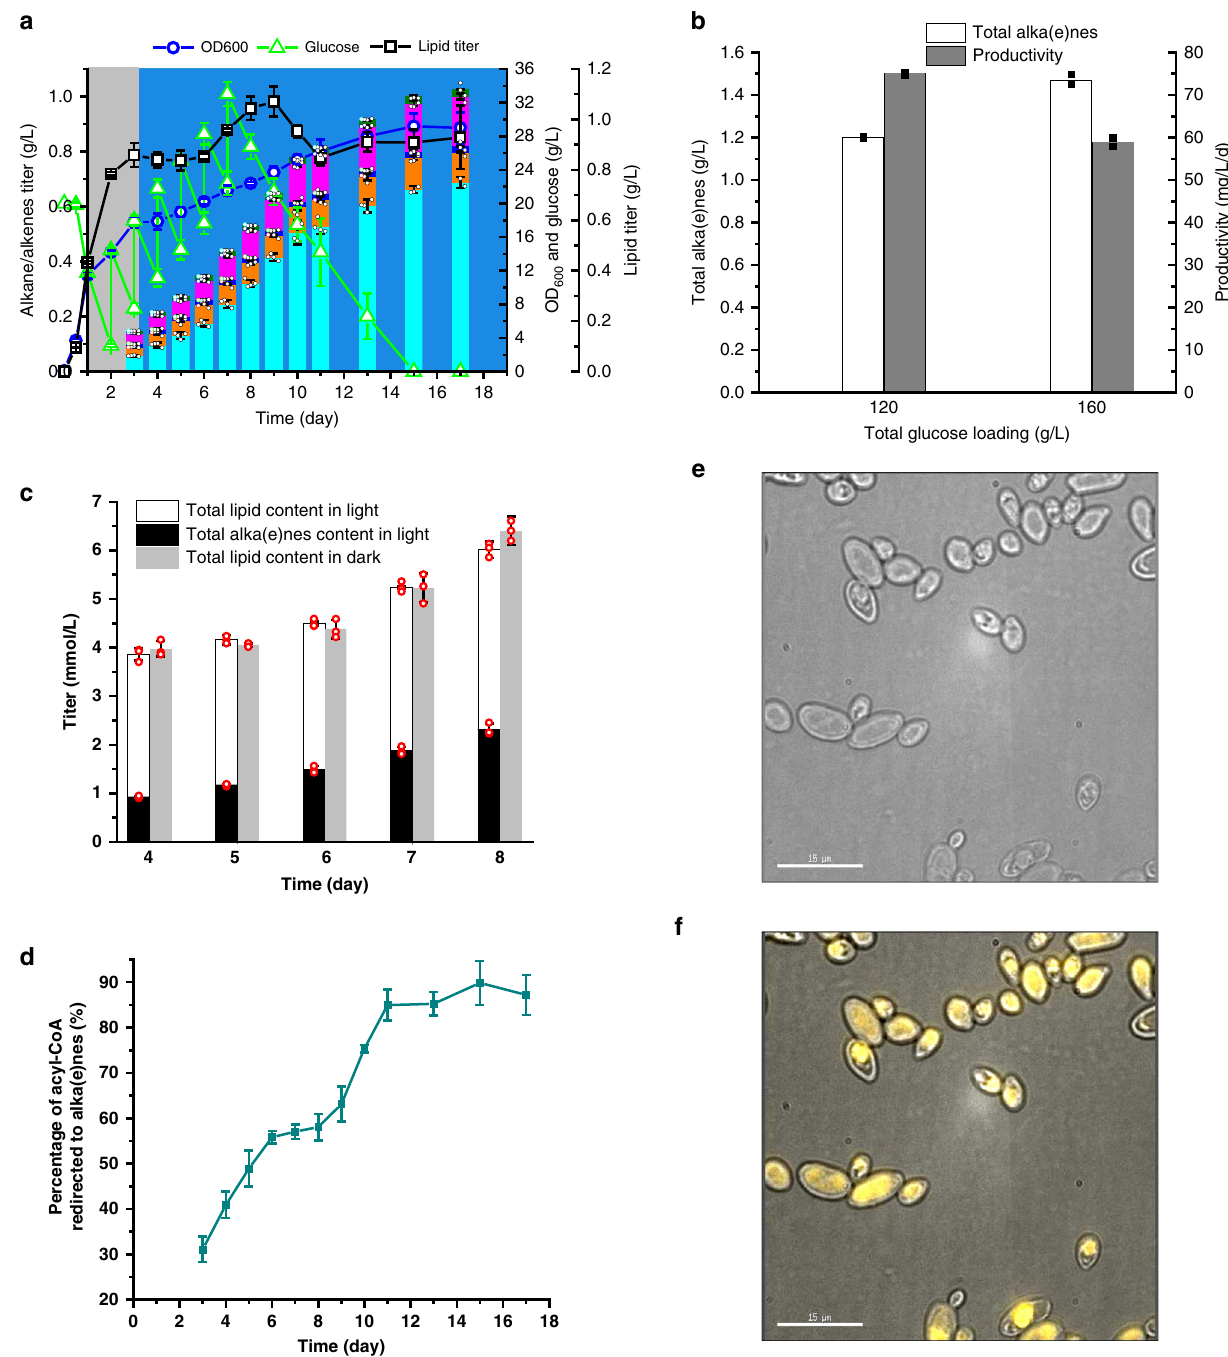
Fig. 4 Redirection of acyl-CoA to form alka(e)nes during fed-batch fermentation process. a Production of alka(e)nes by YLjbl-26 in fed-batch fermentations. Gray-colored regions indicate cultivation in the dark while blue-colored regions indicate cultivation in blue light ( n = 3 or 4 biologically independent samples). b Alka(e)ne titers and productivities from different glucose loadings with the same feeding strategy as ( a ) ( n = 2 biologically independent samples). c The amount of lipids in cells cultured in dark conditions matched the sum of lipids and alka(e)nes in cells cultured in light conditions. Both fermentations were carried out following the same feeding strategy as shown in ( a ). d We further developed a method (Supplementary Note 2) to determine the fraction of the redirected fl ux. This fraction increased from 31% to 85% as fermentation progressed from day 3 to 11, asymptotically reaching a maximum of 89%. e Bright fi eld microscopic images of cells with alka(e)ne titers of 1.03 g/L, equivalent to 89% of neutral lipids. f Fluorescence images of cells (yellow), merged with the bright fi eld images. Staining our alka(e)ne-producing strain reveals that most cells were fi lled with intracellular lipids and alka(e)nes with no evidence of extracellular fl uorescence. Images were taken by a DeltaVision2-TIRF Microscope. Cells were stained by Nile red. Fermentations were performed in 50 mL glass conical shake fl asks with a working volume of 13 mL and an initial OD 600 of 0.1. Blue light was generated by light source 2 (Supplementary Fig. 16). Data represent mean value ± SD, n = 3 or n = 4 biologically independent samples. Source data underlying Fig. 4a – d are provided as a Source Data fi